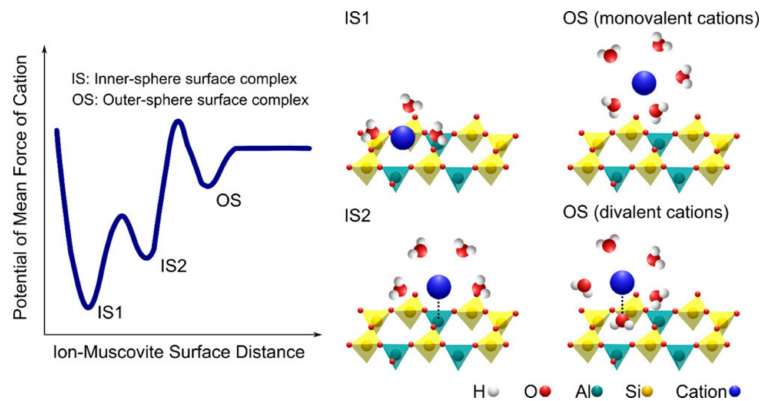
Figure 4. Illustration of the molecular dynamic model of cation distribution on a charged clay mineral surface (mica). See text for a description of adsorption mechanisms. Image adapted from Kobayashi et al. [91] with